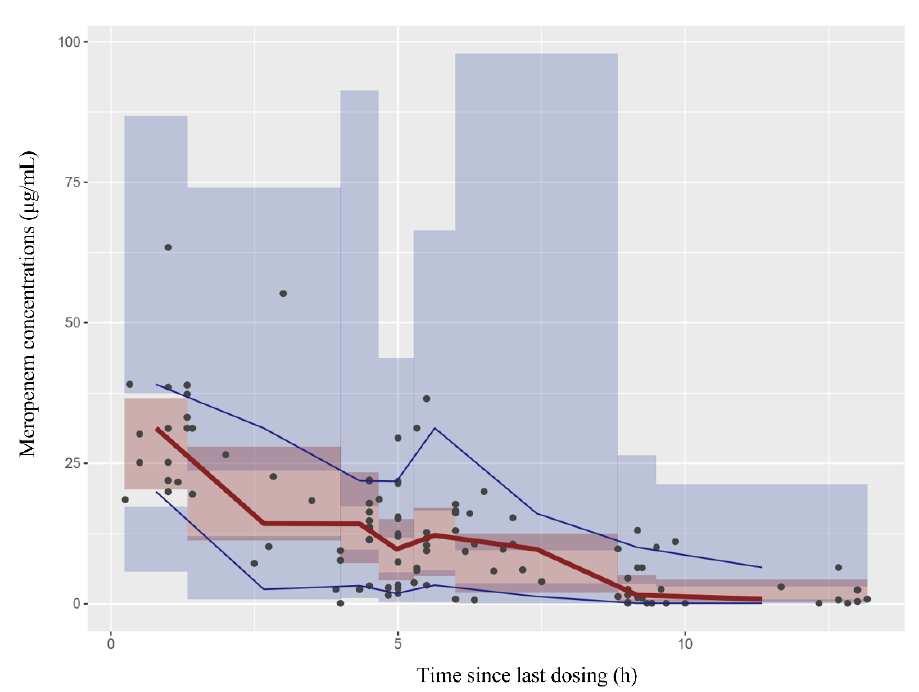
Figure 3. The visual predictive checks. The pink field represents simulation-based 95% confidence intervals for the median and the red line represents the median observed concentrations. The circles represent the observed concentrations. The 95% intervals for the model-predicted percentiles are shown as blue field and the observed 5th and 95th percentiles are indicated by blue lines.